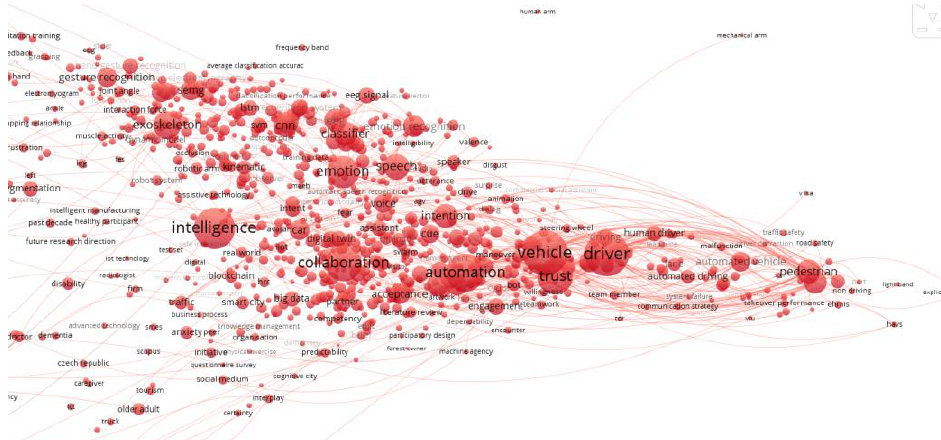
Figure 8. Technology cluster.